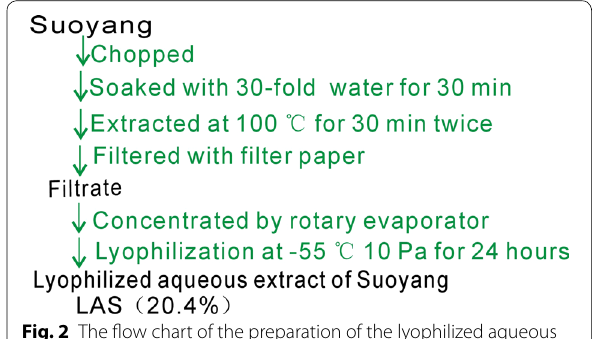
Fig. 2 The flow chart of the preparation of the lyophilized aqueous extract of Suoyang